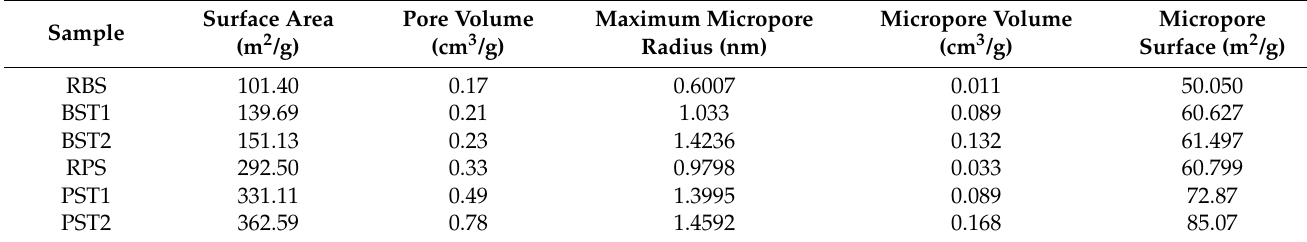
Table 3. Specific surfaces and pore volumes of studied